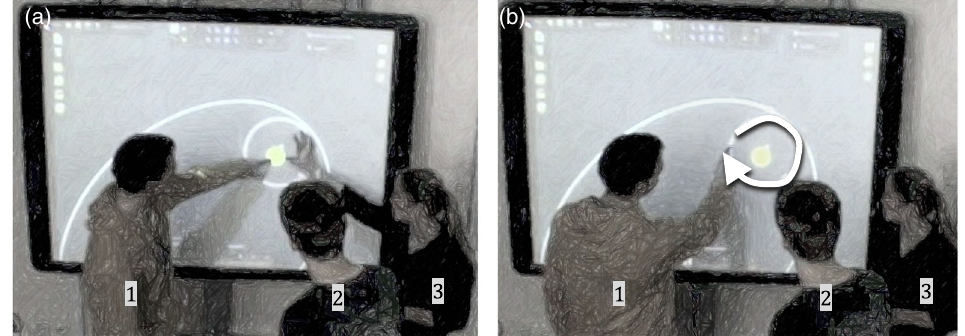
FIG. 2. In (a), two students (1 and 3) are pointing out that the Sun is not in the center of what looks like a circular-shaped orbit. Student 1 is pointing to the Sun, while formulating a verbal description of the visual characteristics of the orbits, as they are made visually available by tracers. Student 3 uses her hand to indicate the distance between the Sun and the orbit on one side, where the distance is the largest. In (b), student 1 uses another symbiotic gesture to describe the motion and orbital shape of the planet in a circlelike orbit. In this case, the symbiotic gesture allows the student to explicate the discerned features of the phenomena of interest by locating them in the setting itself, highlighting them, and thus bringing them to the attention of